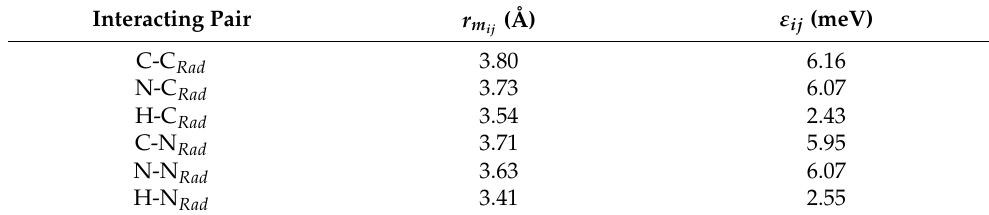
Table 5. Parameters for the non-electrostatic potential. Note that 1 meV = 0.09648534 kJ · mol − 1 [39]. Interacting